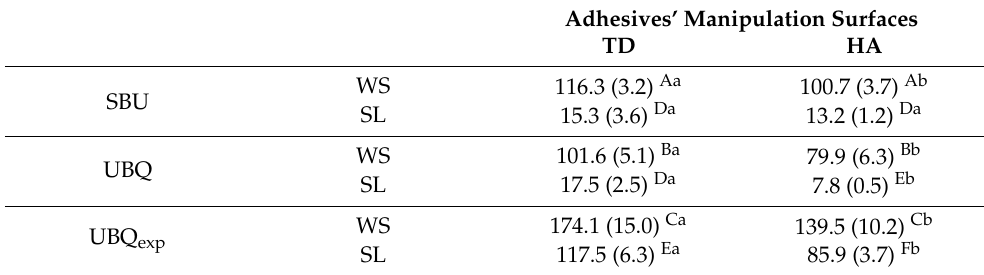
Table 3. Mean (SD) Water sorption [ µ g/mm 3 ] and solubility [ µ g/mm 3 ] values of 1-SEAs.